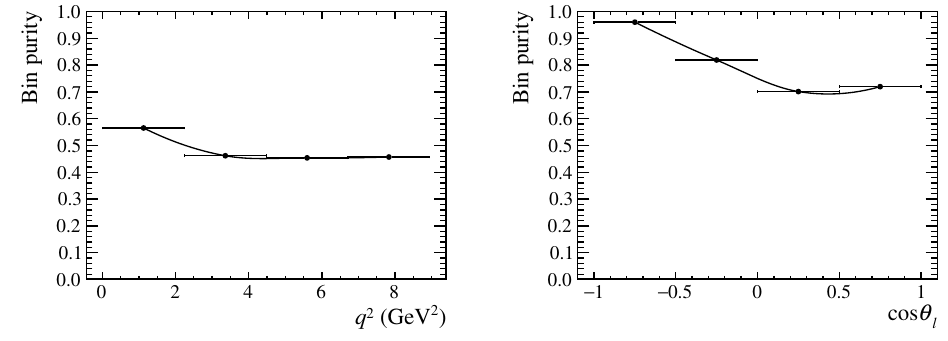
Figure 1 . Purity as a function of q 2 and cos (cid:18) l , de(cid:12)ned as the fraction of candidates which belong in a particular kinematic bin. The purity for cos (cid:18) l is better than for q 2 due to the better